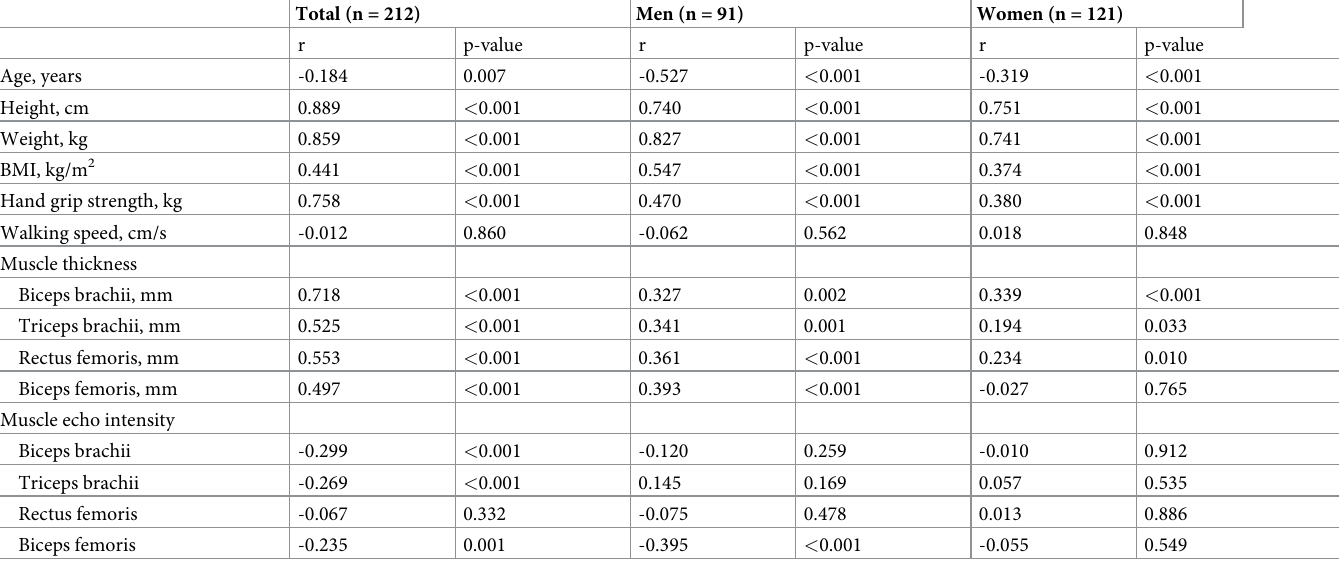
Table 2. Correlation analysis between clinical parameters and appendicular skeletal muscle mass.